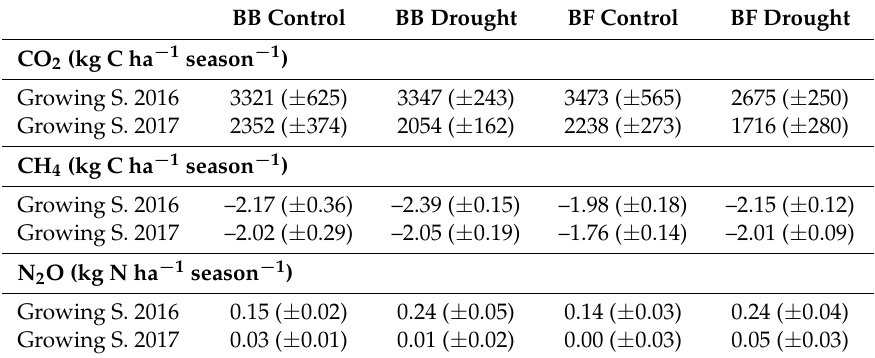
Table A2. The seasonal cumulative flux rates of soil respiration (CO 2 ), CH 4 and N 2 O of the control (no roof) as well as drought treatment (roof) of the pure beech (BB) and mixed beech-fir stand (BF); mean ( ±